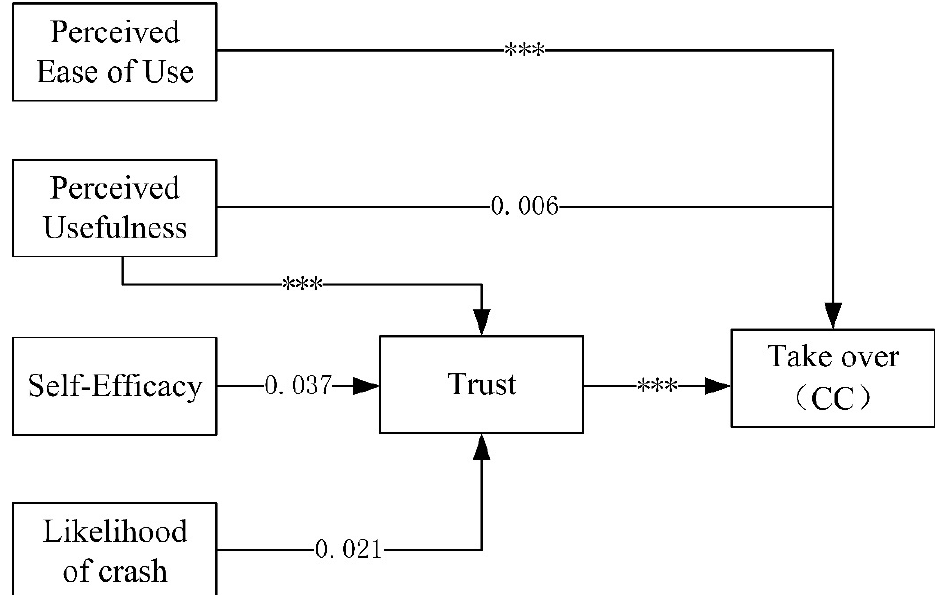
Figure 2. Value of CC model Notes: *** p < 0.001.